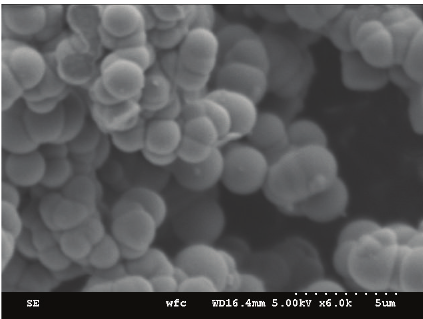
Figure 1: SEM micrograph of Ag-TiO 2 sintering at 550 ◦ C ( × 6.0k).